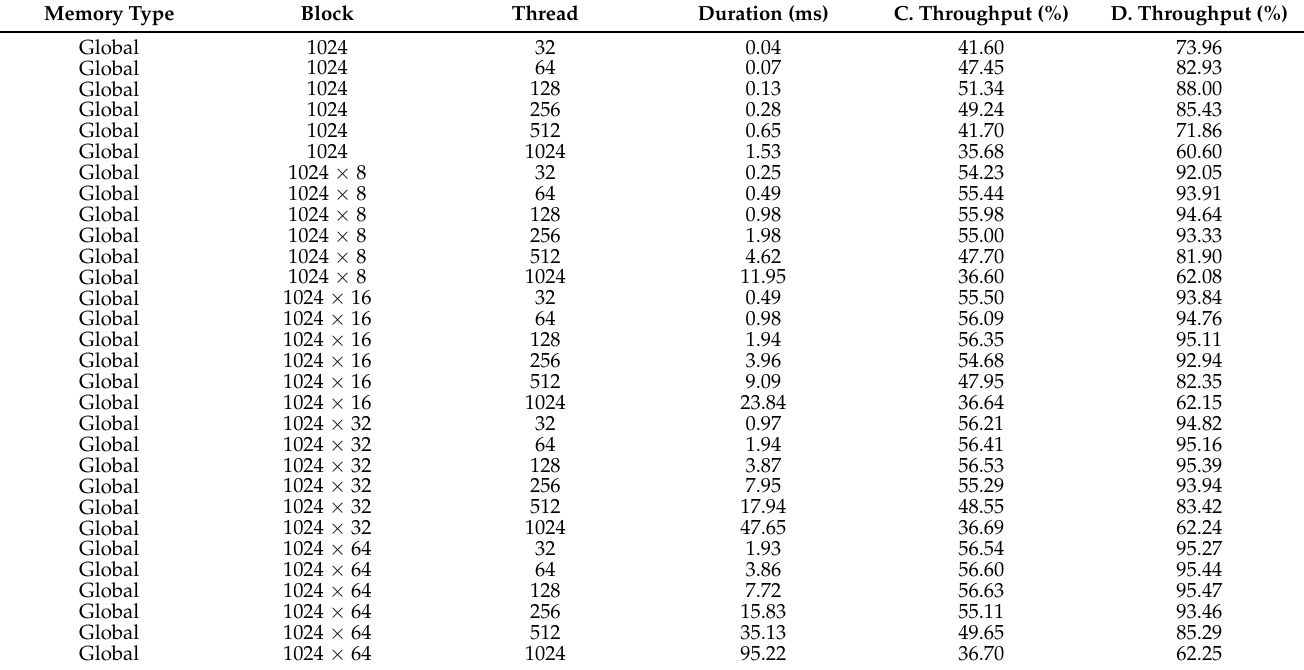
Table 7. Performance of all the global memory implementation (C.: compute, M.: memory).